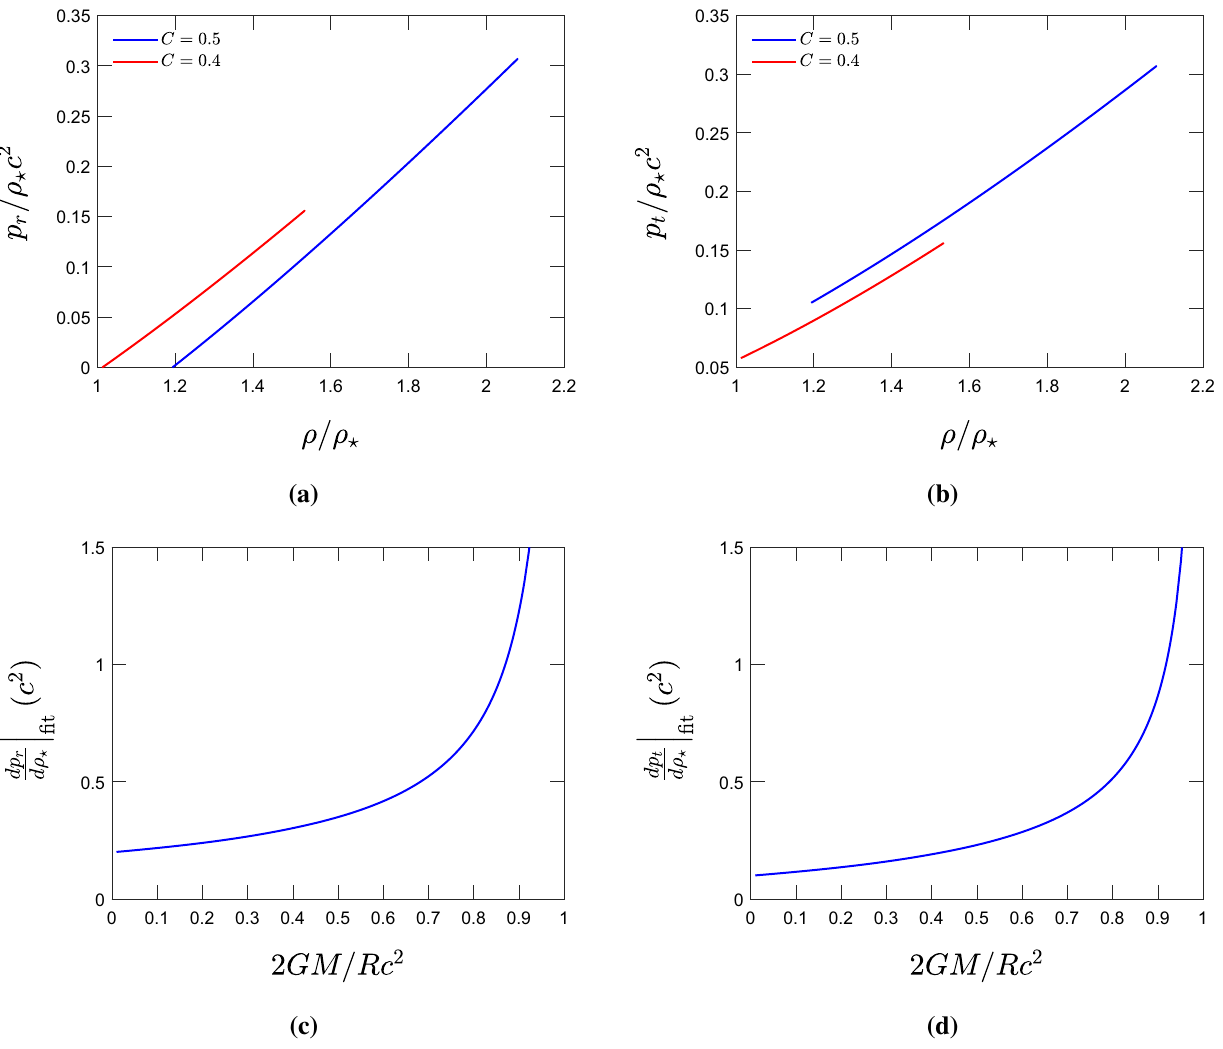
Fig. 1 In the upper panel is depicted the equation of state p = p (ρ) for the radial and tangential pressures. In the lower panel we draw the slope of the linear fit of p = p (ρ) for the radial and tangential pressures with respect to the compactness of the star